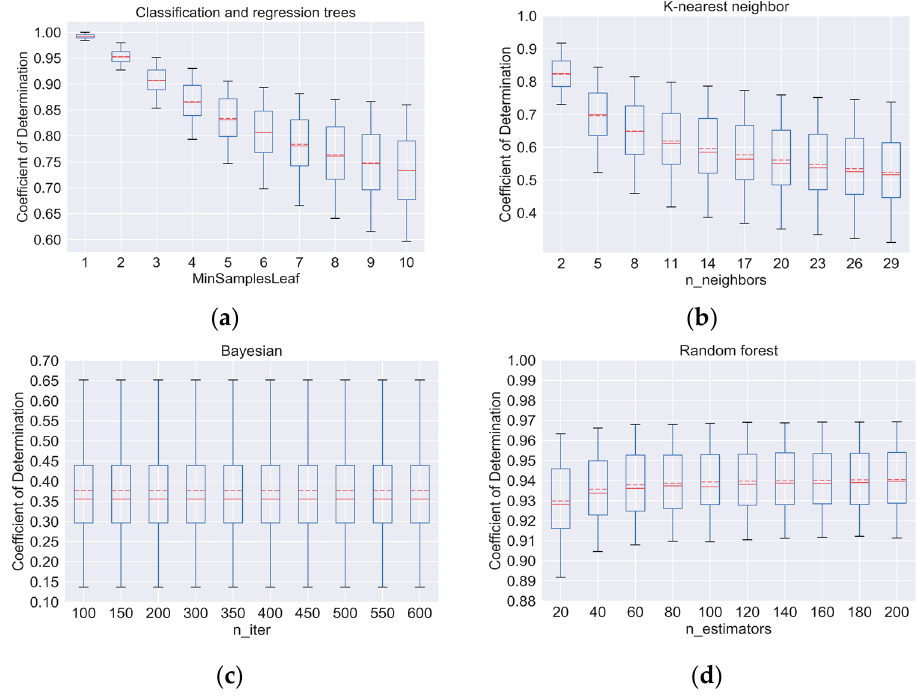
Figure 3. Variations of coefficient of determination with different selected parameters of: ( a ) classification and regression trees; ( b ) K-nearest neighbors; ( c ) Bayesian; and ( d ) random forest.